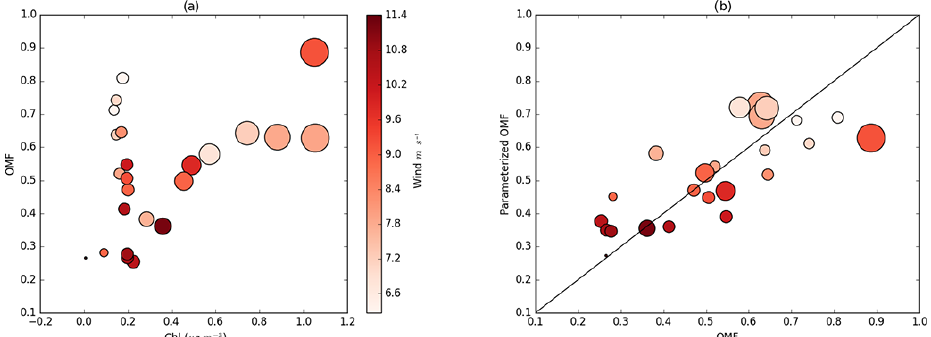
Figure A2. (a) OMF compared as a function of chlorophyll a content and surface wind speed for the monthly mean values in both stations. The size of the points represent the mean chlorophyll a content of the grid boxes related previously to every station (Fig. A1), the colour of the points is related to the wind speed of those grid boxes. Panel (b) shows the performance of the parameterization for reproducing the OMF calculated with the simulated concentration of submicron sea salt and the observed values of WIOM. The parameterization for the OMF